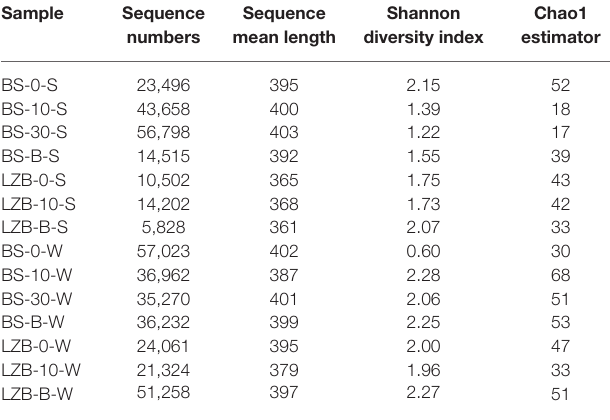
TABLE 2 | High-throughput sequencing information and alpha diversity